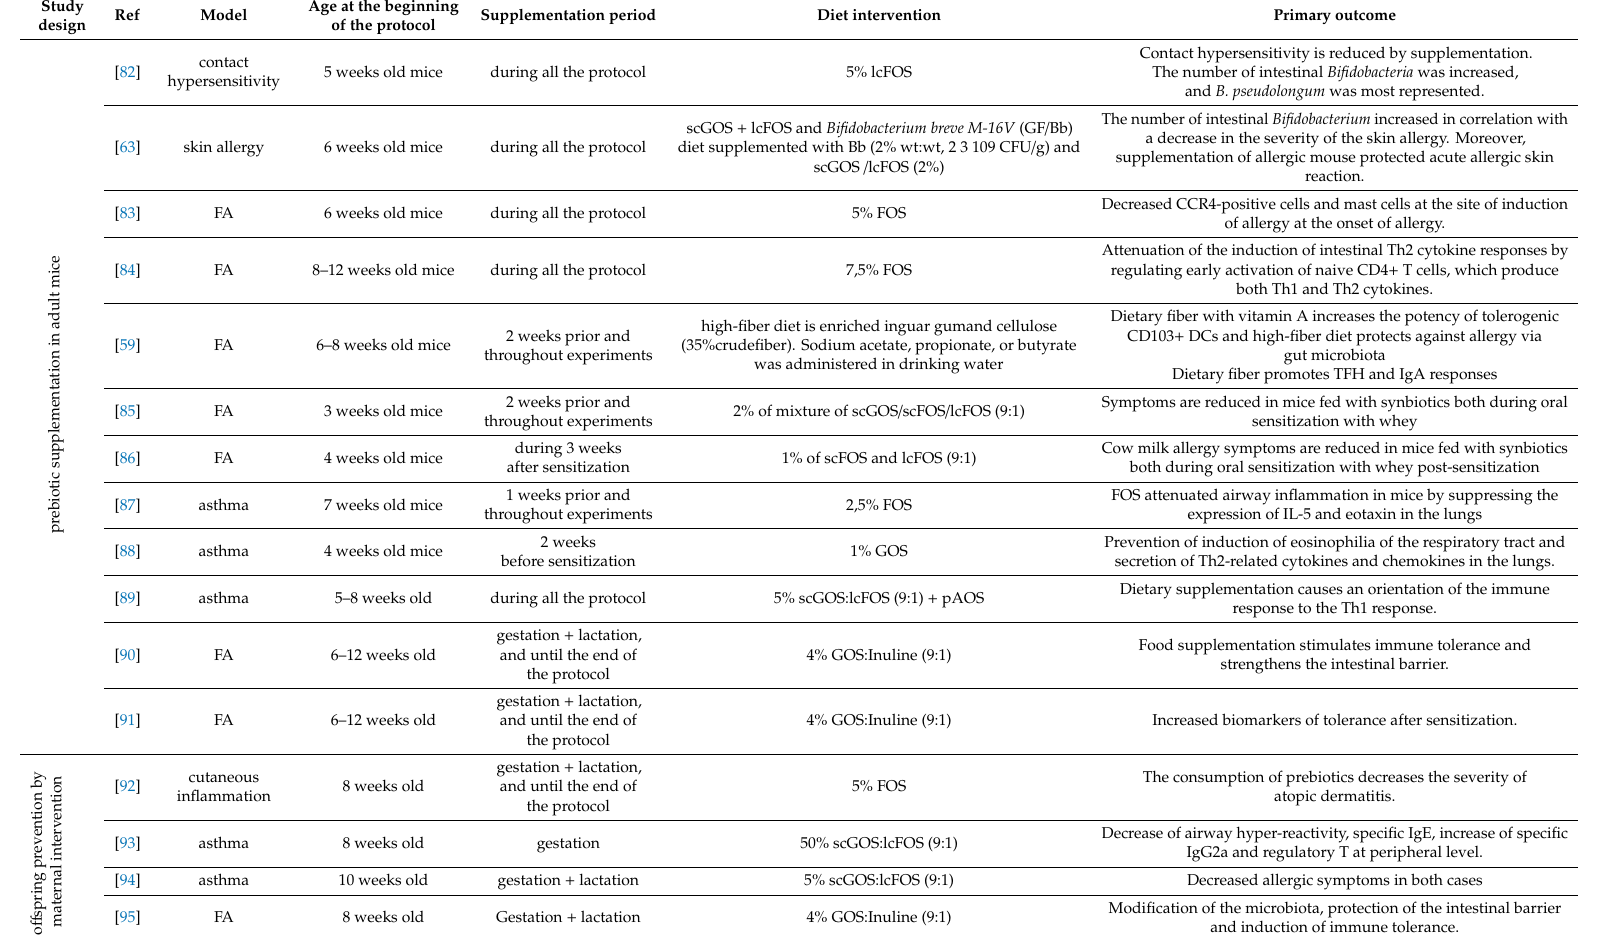
Table 2. Preclinical studies with prebiotics for allergy